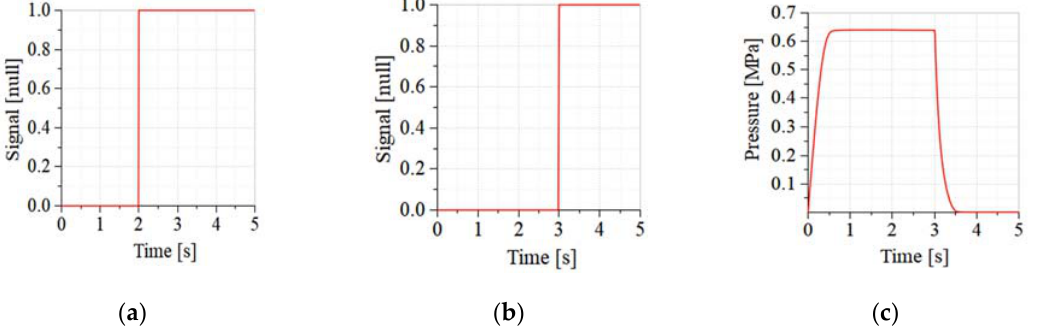
Figure 10. Curves of ABS pressure regulator control signal and pressure response of brake chamber. ( a ) Control signal of the pilot inlet solenoid valve; ( b ) control signal of the pilot exhaust solenoid valve; ( c ) pressure of the brake chamber under control signals of ( a ) and ( b ).